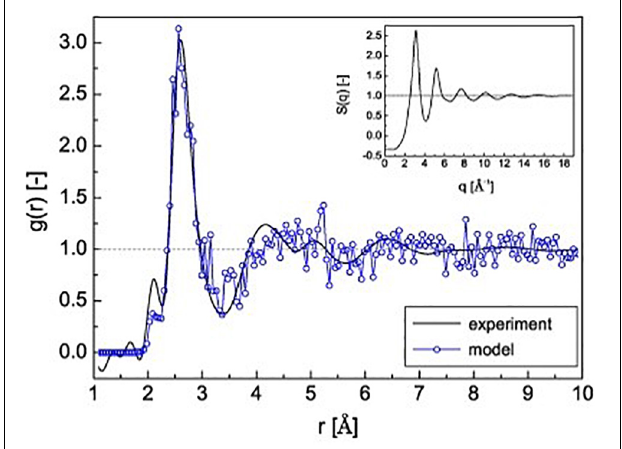
FIGURE 1 | Pair distribution function g(r) of experimentally and ab initio calculated Co 45 . 5 Fe 24 Ta 6 B 24 . 5 . Inset: structure factor S(q) of the experimental sample (Hostert et al., 2011). © IOP Publishing. Reproduced from Hostert et al. (2011) with permission from IOP. All rights reserved.